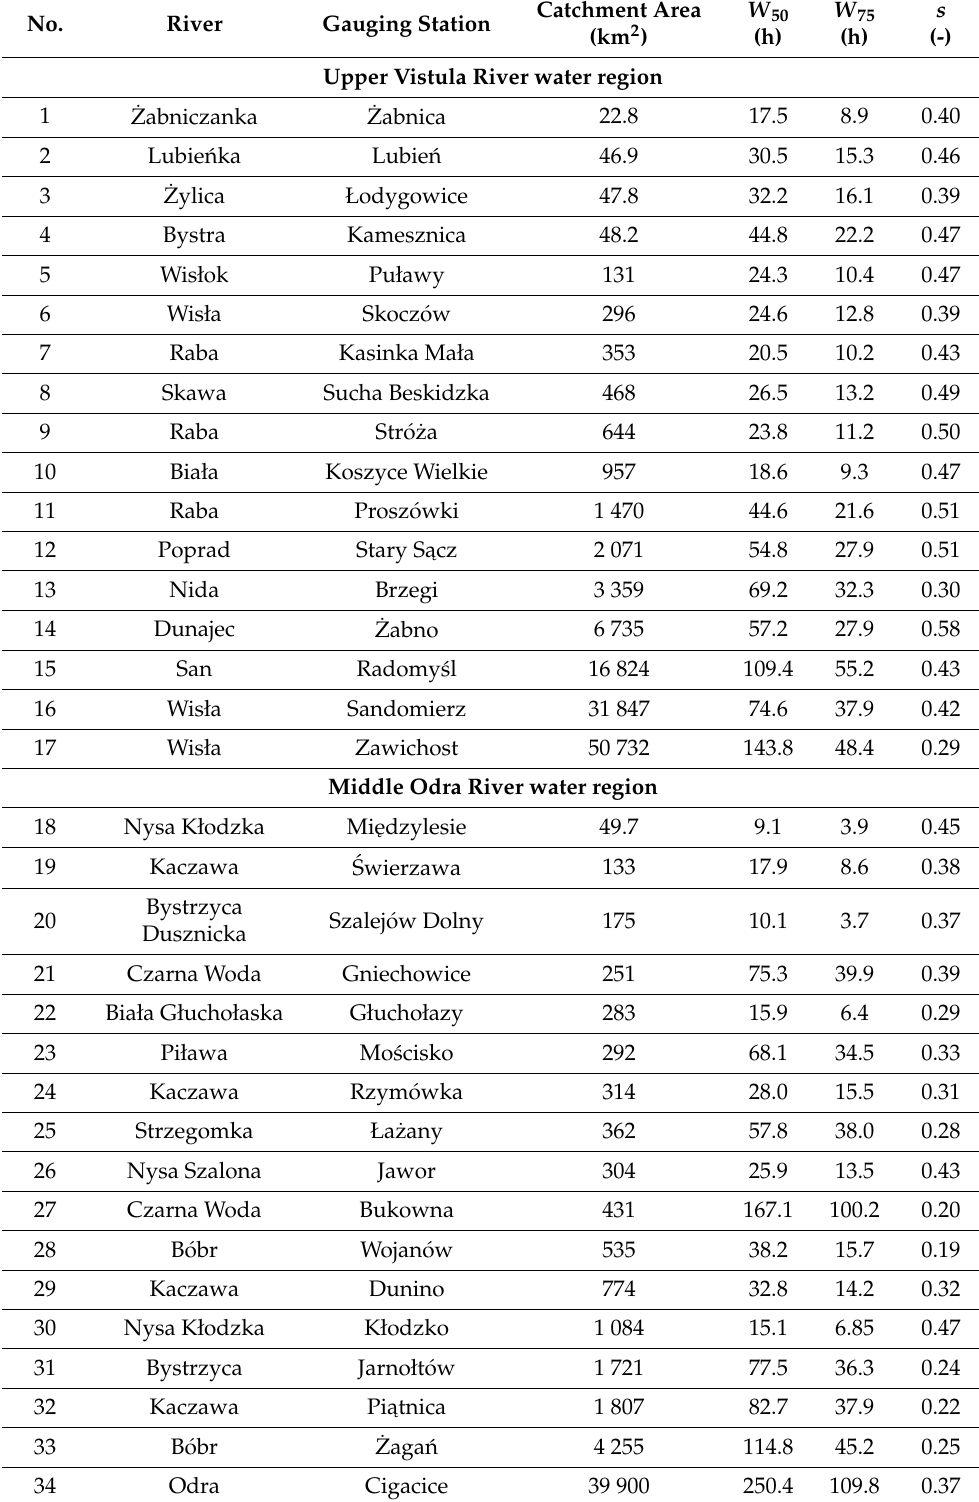
Table 1. Values of hydrograph descriptors W 50 , W 75 and s developed with the use of the Archer